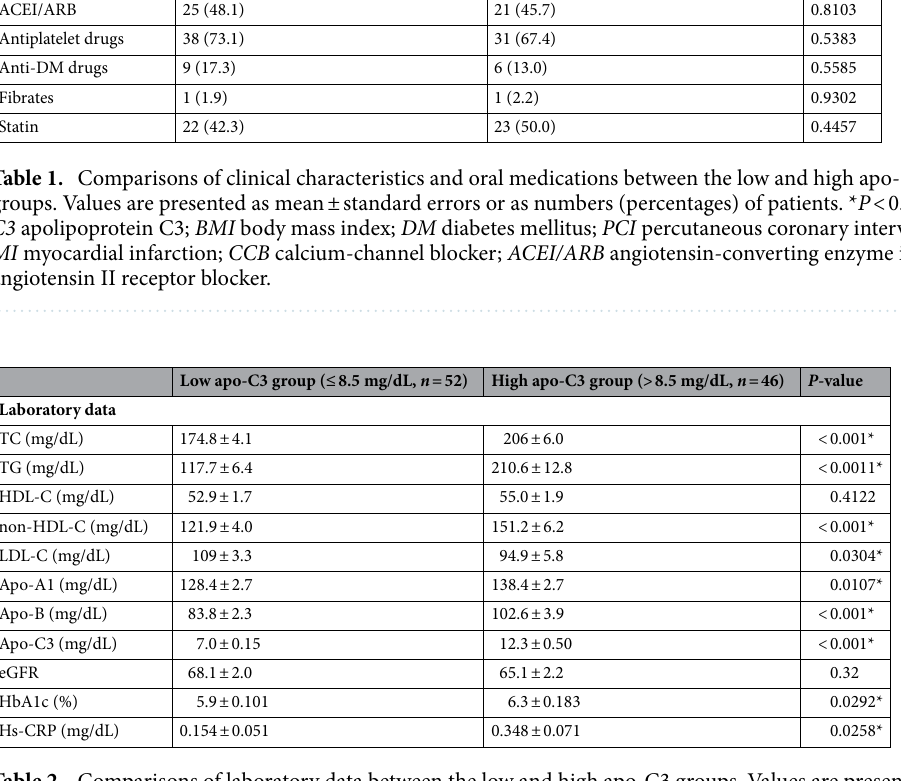
Table 2. Comparisons of laboratory data between the low and high apo-C3 groups. Values are presented as mean ± standard errors. * P < 0.05. apo-C3 Apolipoprotein C3; TC Total cholesterol; TG , Triglyceride; HDL-C High-density lipoprotein cholesterol; LDL-C Low-density lipoprotein cholesterol; eGFR Estimated glomerular filtration rate; HbA1c hemoglobin A1c; hs-CRP High-sensitivity C-reactive